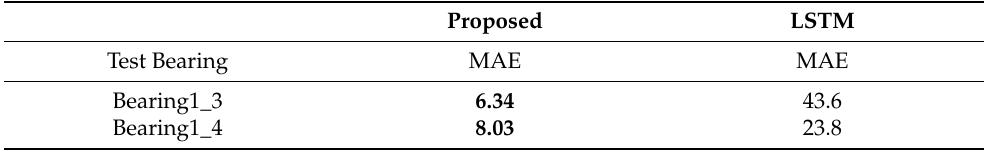
Figure 12. The MAE of predicted RUL results by the Wiener–LSTM model and LSTM model. ( a ) The MAE of predicted results on test bearing1_3. ( b ) The MAE of predicted results on test bearing1_4. The blue line is the MAE of results by using the Wiener–LSTM model. The orange line is the MAE of results by using the LSTM model. Table 2. Numerical prognostic performance comparisons of different